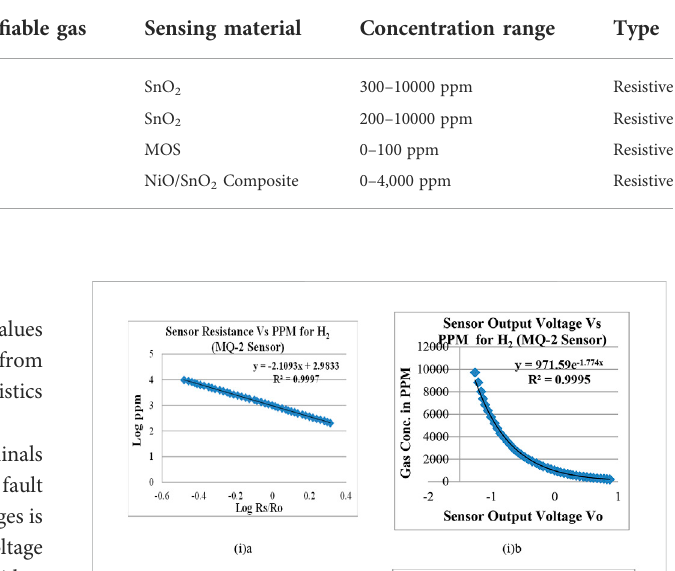
TABLE 2 Speci fi cations of gas sensors.